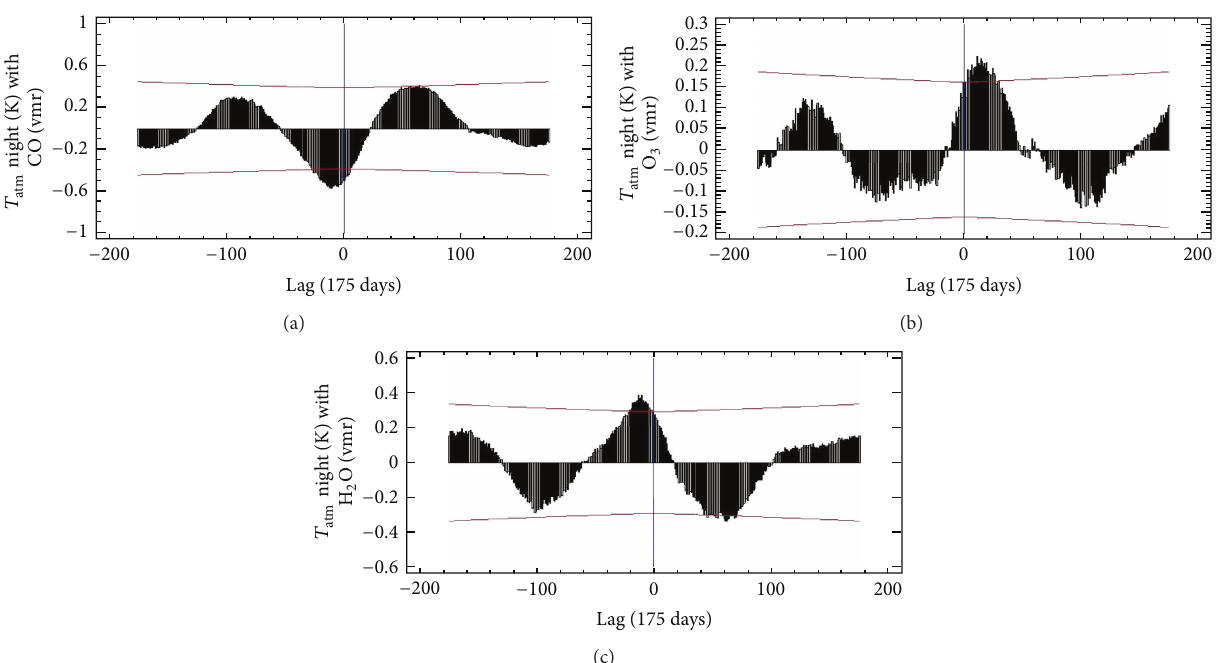
Figure 7: Cross correlation of night atmospheric temperature with CO, ozone, and water vapor,